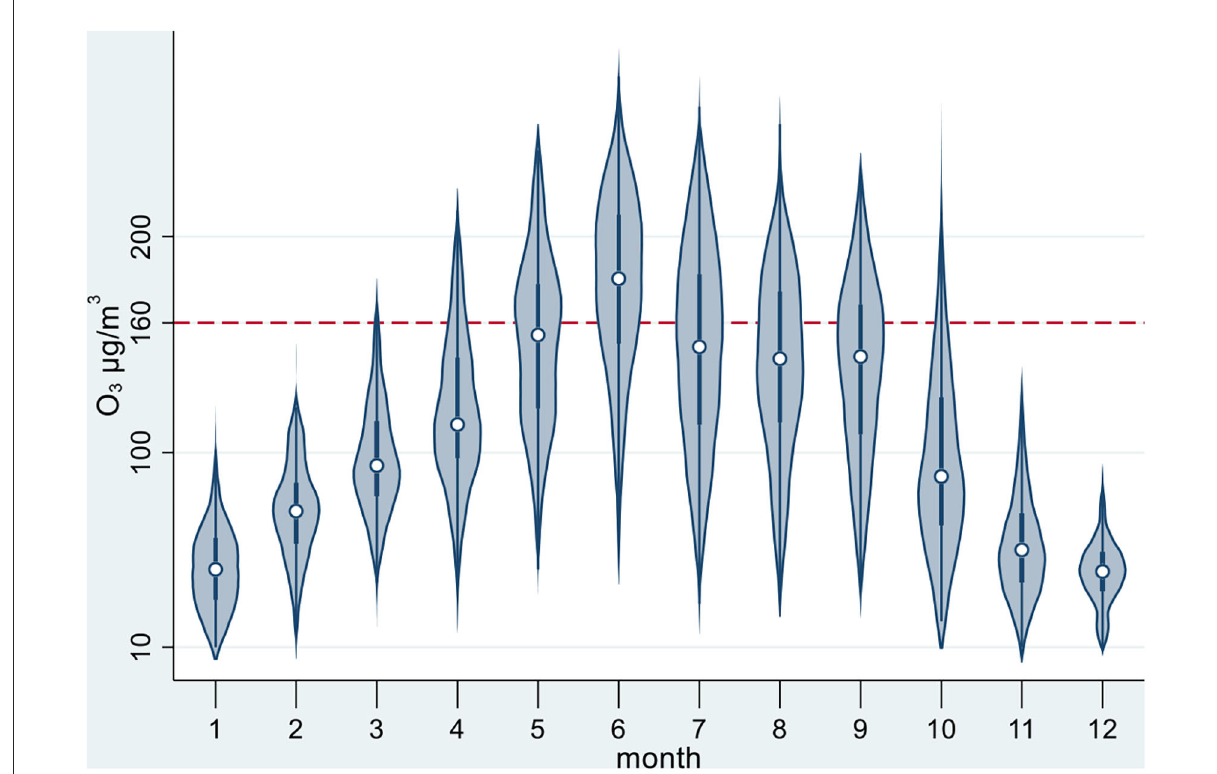
FIGURE2 Probability distributions of MDA8 O 3 concentration in 12 months during 2013–2020 in Jinan